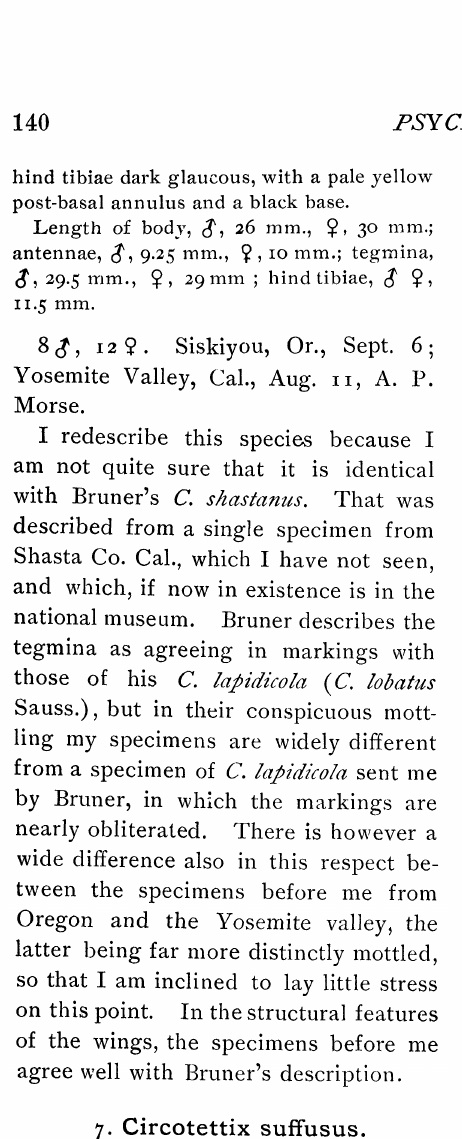
hind tibiae dark glaucous, with a pale yellow post-basal annulus and a black